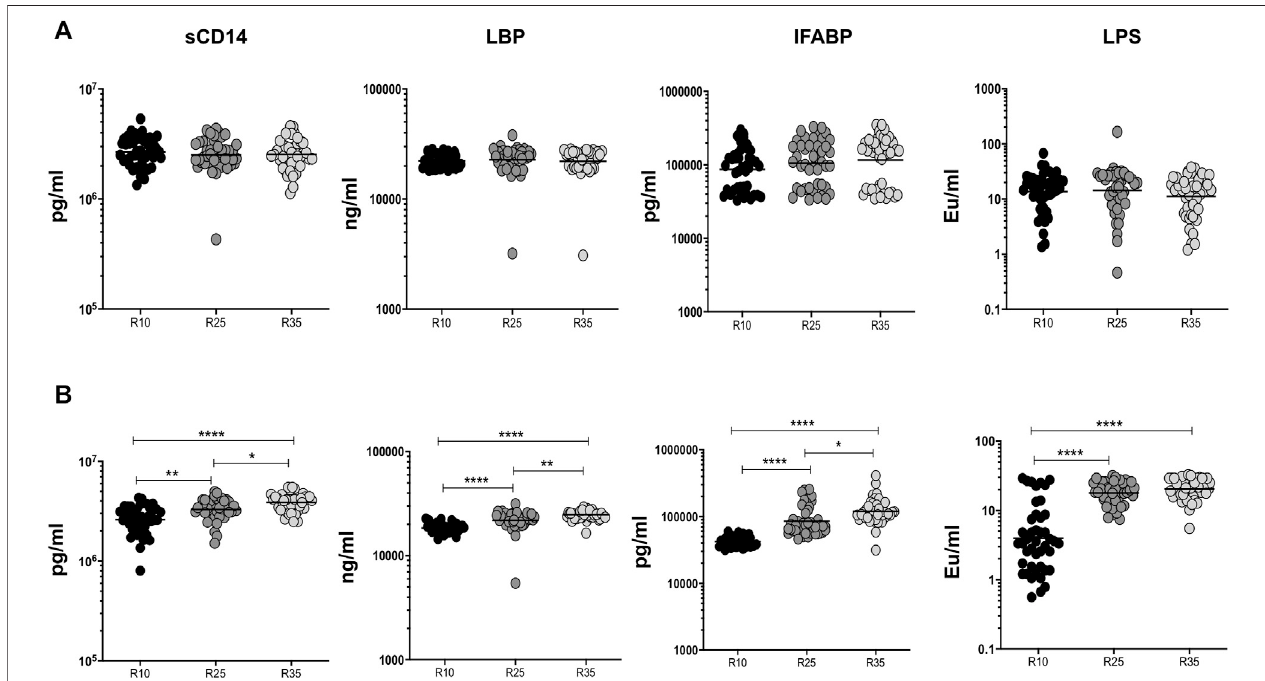
FIGURE 4 | High dose rifampicin is associated with elevated MTMs at second month in PTB individuals. (A) Baseline plasma levels of MTMs (sCD14, LBP, IFABP, and LPS) between the three different rifampicin (R10 [n = 44], R25 [ n = 44], R35 [ n = 44]) treated arm of PTB individuals. (B) Second month plasma levels of MTMs (sCD14, LBP, IFABP, and LPS) between the three different rifampicin (R10 [ n = 44], R25 [ n = 44], R35 [ n = 44]) treated arm of PTB individuals. We used Kruskal – Wallis test with Dunn ’ s multiple comparisons to measure the p values and each individual were denoted using scatter